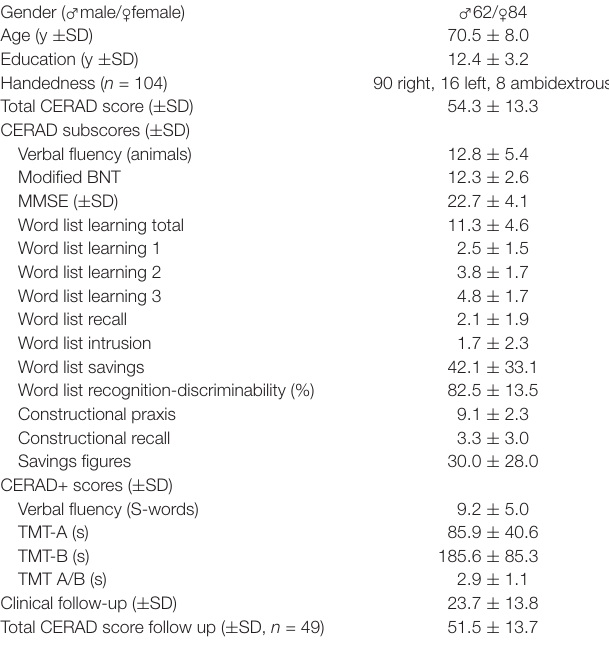
TABLE 1 | Demographic and clinical data of the study population ( n =